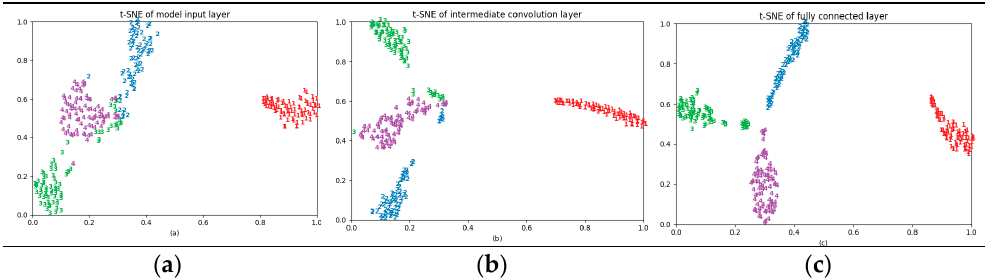
Figure 14. T-SNE visualization: ( a ) the model input layer; ( b ) the intermediate convolutional layer; ( c ) the fully connected layer.